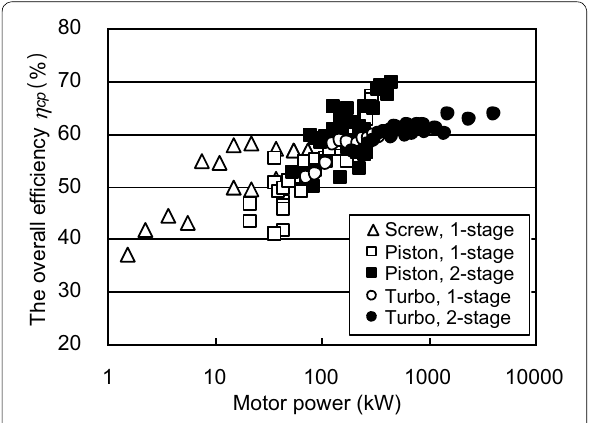
Figure 6 The overall efficiencies of